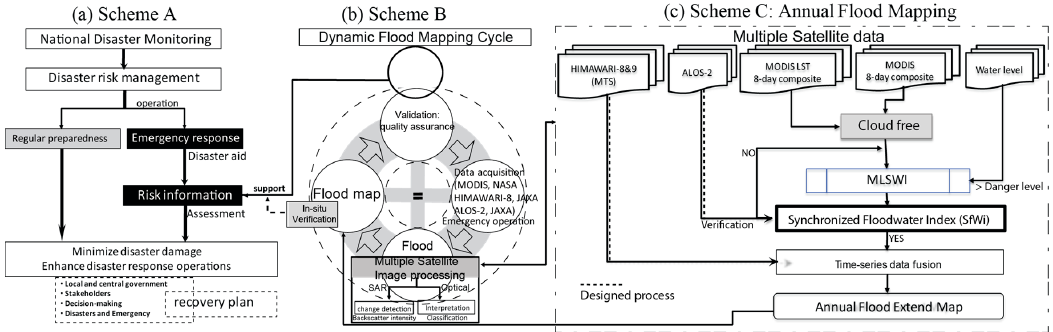
Figure 1. Framework of nationwide monitoring for supporting emergency risk management. Table 1. Used data including designed process for 2015 flood